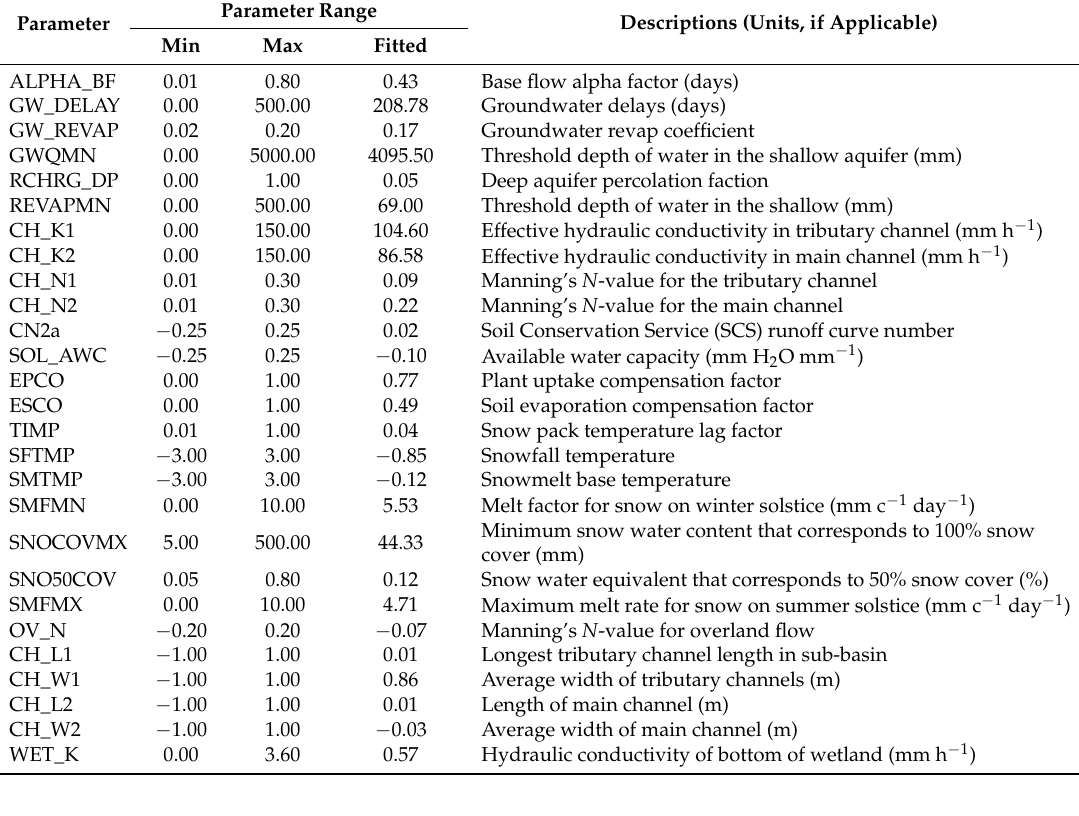
Table 2. Soil Water Assessment Tool (SWAT) parameters used for calibrating the modified SWAT model. Parameter Range Parameter